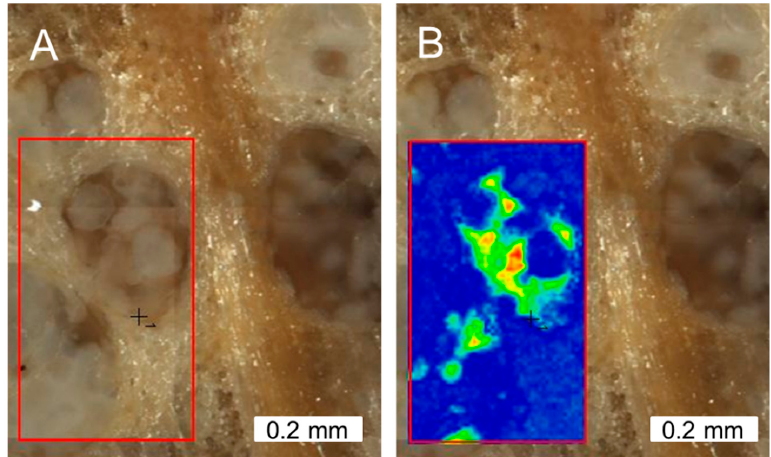
Figure 14. Moganite in a chalcedony-preserved early wood vessel. ( A ) OM image with field of view; ( B ) OM image with overlay of the Raman map generated from the 502-cm − 1 peak intensity showing high (red) and low (blue) moganite content.